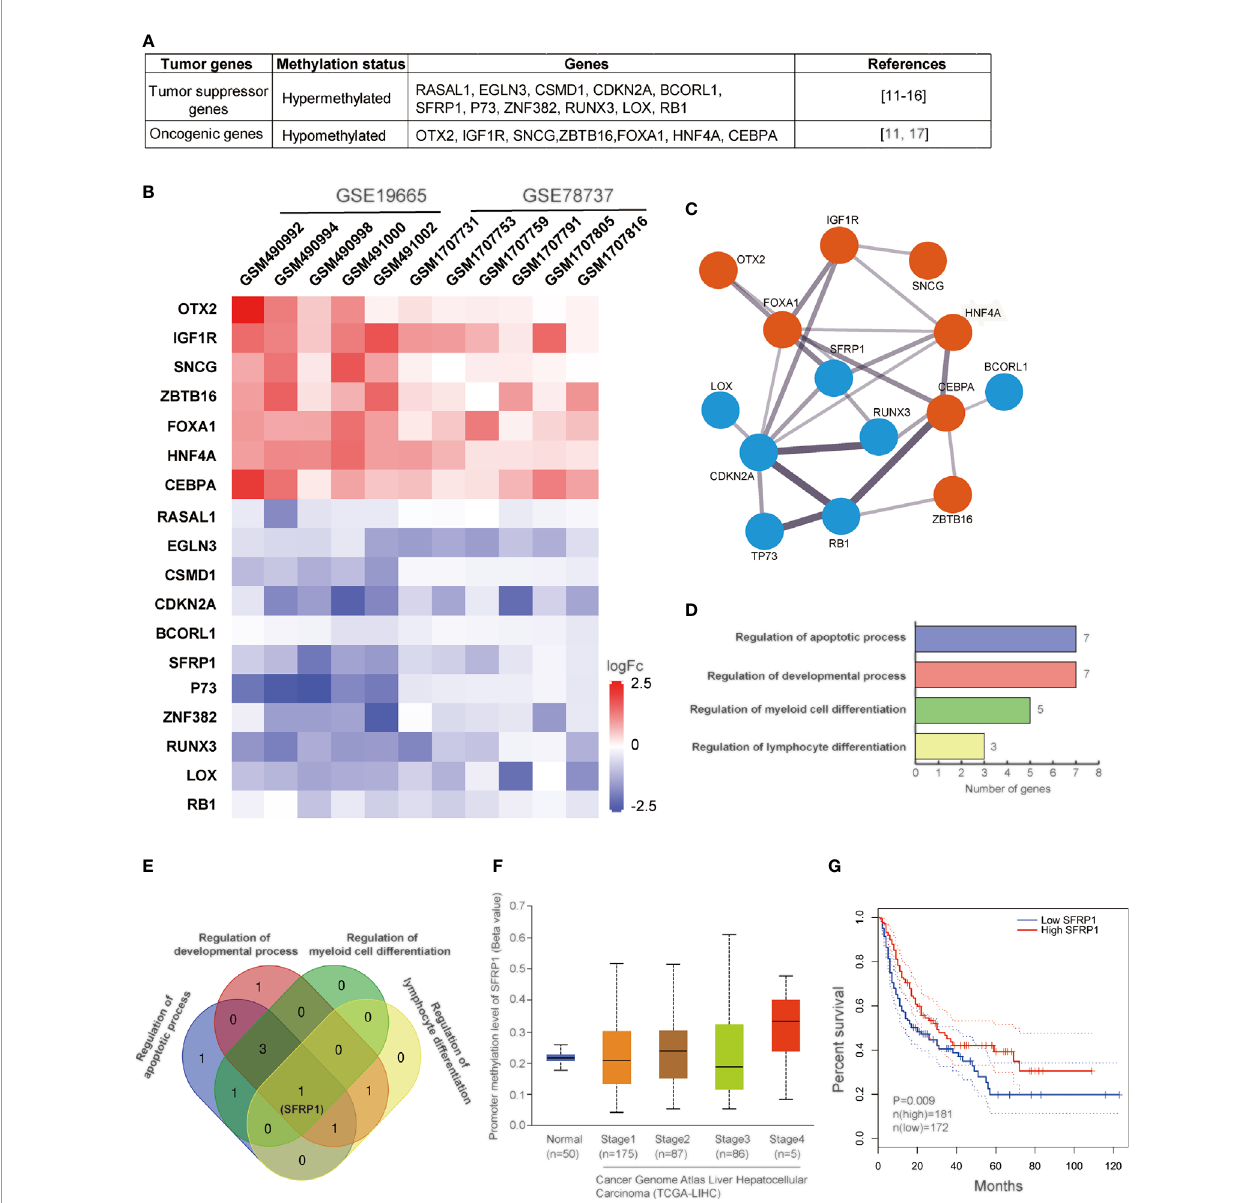
FIGURE 1 | Methylation analysis of genes in HCV-induced HCC. (A) Table of 11 tumor suppressor genes and 7 oncogenic genes regulated in HCV-induced HCC. (B) Heatmap of the correlation between the expression levels of 18 genes and HCV-infected HCC samples among TCGA data sets. The output thresholds are FDR < 0.05, P < 0.05 and |log2 FC| > 1. (C) Functional interaction network of 14 genes. Protein interactions are presented by STING online tool (https:// stingnetwork.com). Blue dots indicate down-regulated, red, up-regulated. Line thickness indicates the strength of interactions. (D) The biological processes with 18 genes are analyzed. There are four different processes involving in corresponding genes. Gene Ontology analysis is conducted using online website PANTHER Tools (http://pantherdb.org/data/). (E) Venn results of 18 genes which are regulated in the four biological processes. It is showed that only SFRP1 is commonly regulated in all biological processes. (F) The DNA methylation levels of SFRP1 in clinicopathological stages of HCC in the TCGA data set. (G) Kaplan – Meier curves showing that patients with different expression levels of SFRP1 had different overall